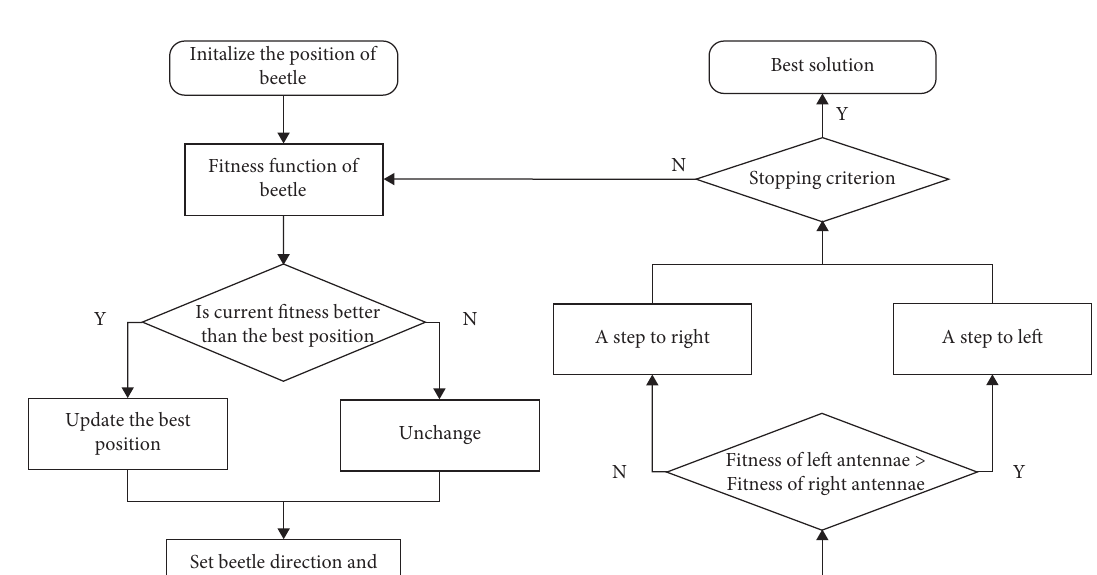
Figure 2: Diagram of SVM.